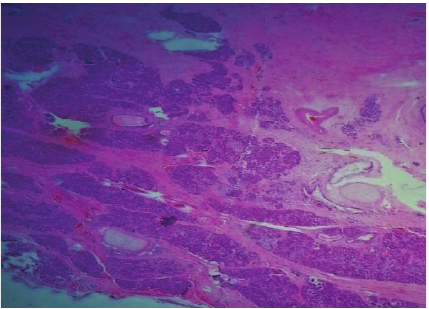
Figure 6: HE (hematoxylin and eosin) × 50 showed cartilaginous coating and pancreatic parenchyma.